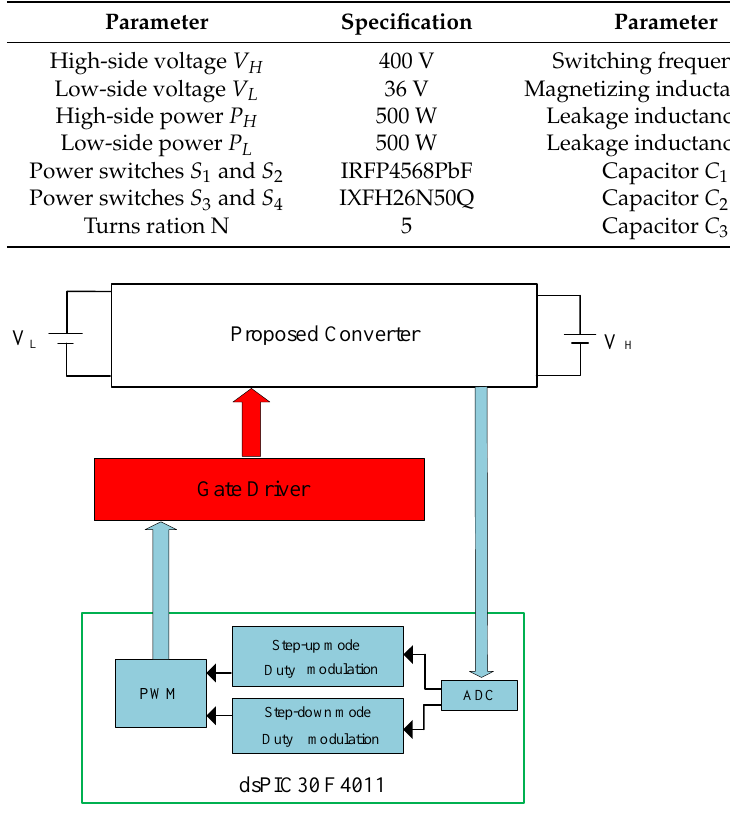
Figure 13. The control scheme of the proposed converter.